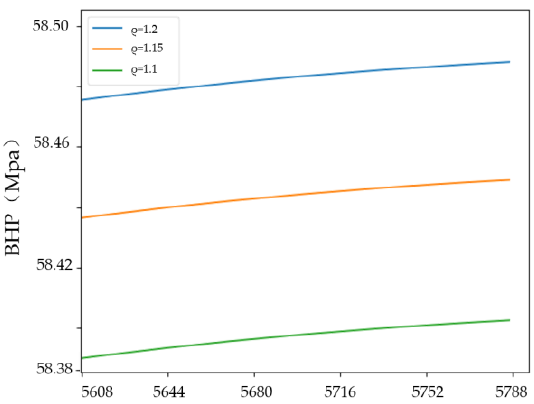
Figure 10. Effect of changing well depth on BHP with different drilling fluid